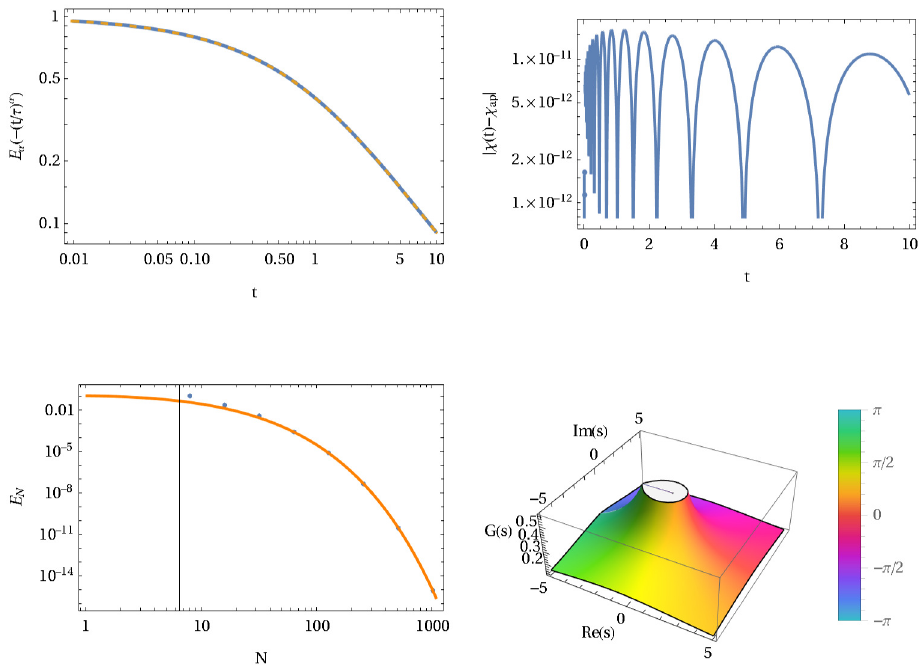
Figure 7. Solution of the fractional relaxation Equation (90) generated by the inverse Laplace transform of G ( s ) . The left panel on top also includes the exact solution of the fractional relaxation equation given by χ ( t ) = χ 0 E α ( − ( t / τ ) α ) , where E α ( t ) is the one parameter Mittag-Leffler function. The right panel on top shows the local error between the exact solution and the approximation. The number of approximation points used in the calculation was m = 2 N + 1 = 1025. The parameters to generate the plot are χ 0 = 1, τ = 1, α = 3/4. The bottom panels (left) show the error decay √ (cid:16) (cid:17) 1/2 − k N exp as a function of Sinc points N , E N ∼ . Dots represent numerically determined 1 N L 2 norms, and the solid line represents Equation (57) with c = 0, where K 1 and k 1 are adapted accordingly. The right panel shows the pole structure with a branch cut along the negative real axis of the transfer function G ( s ) on the complex plane C